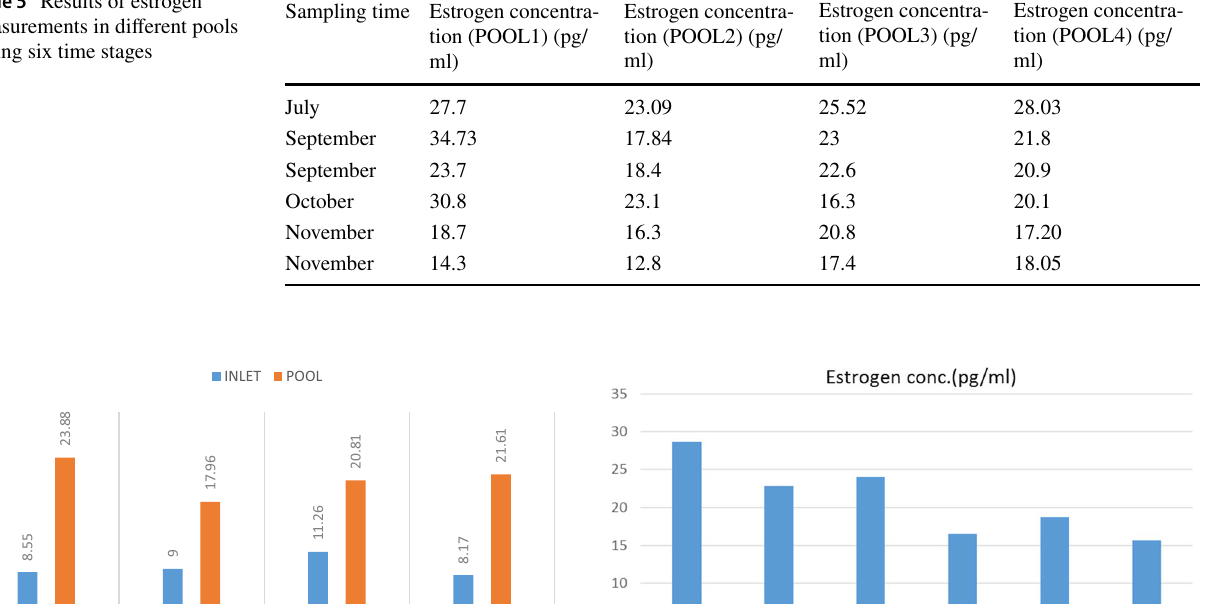
Table 5 Results of estrogen measurements in different pools during six time stages